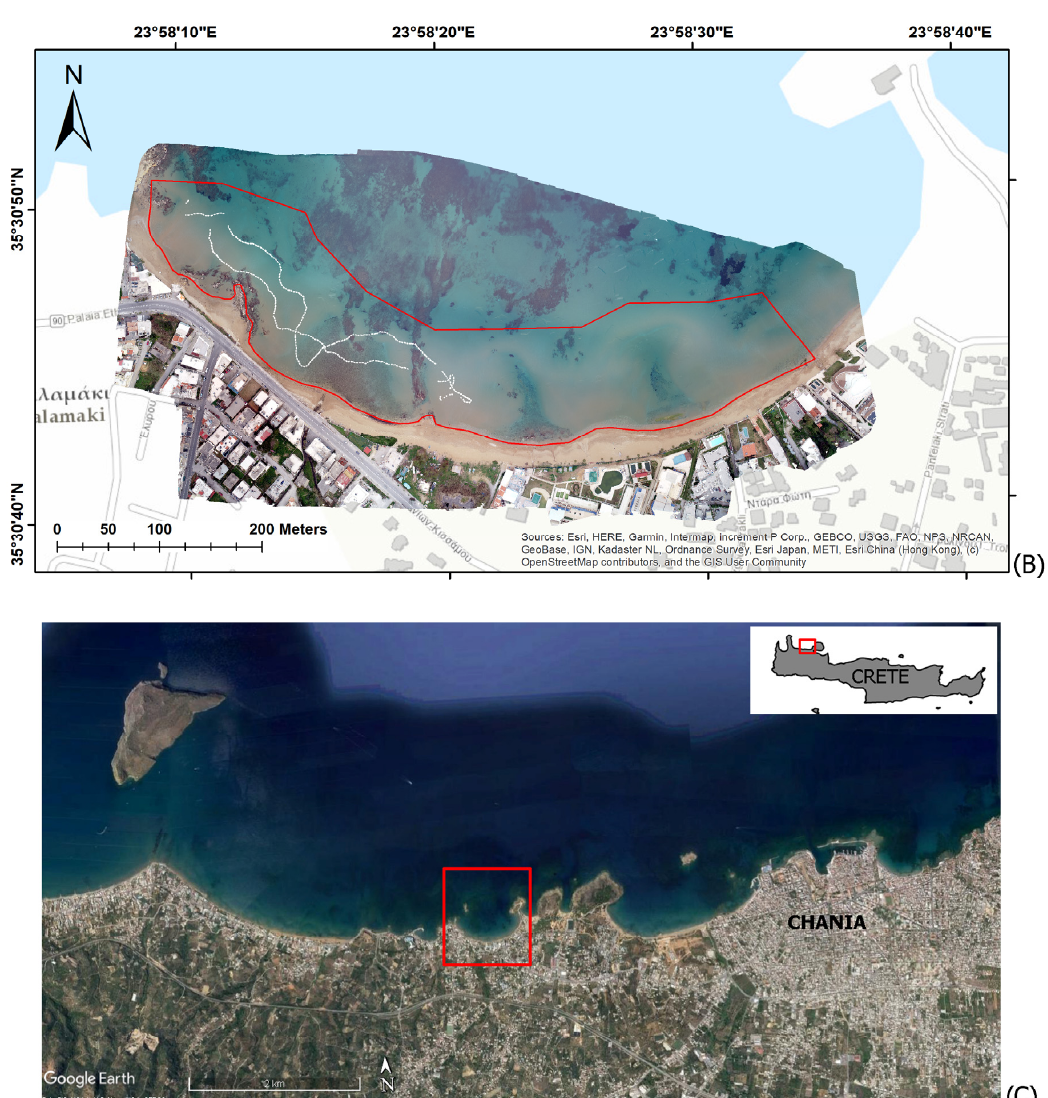
Figure 1. Temporal, true-color orthomosaics of the study area: ( A ) Imagery acquired on 4 November 2021; ( B ) Imagery acquired on 31 March 2022; ( C ) Legend map of the wider study area. The red rectangles show the processing boundaries of bathymetry inversion, and the white dots correspond to the track of USV sonar